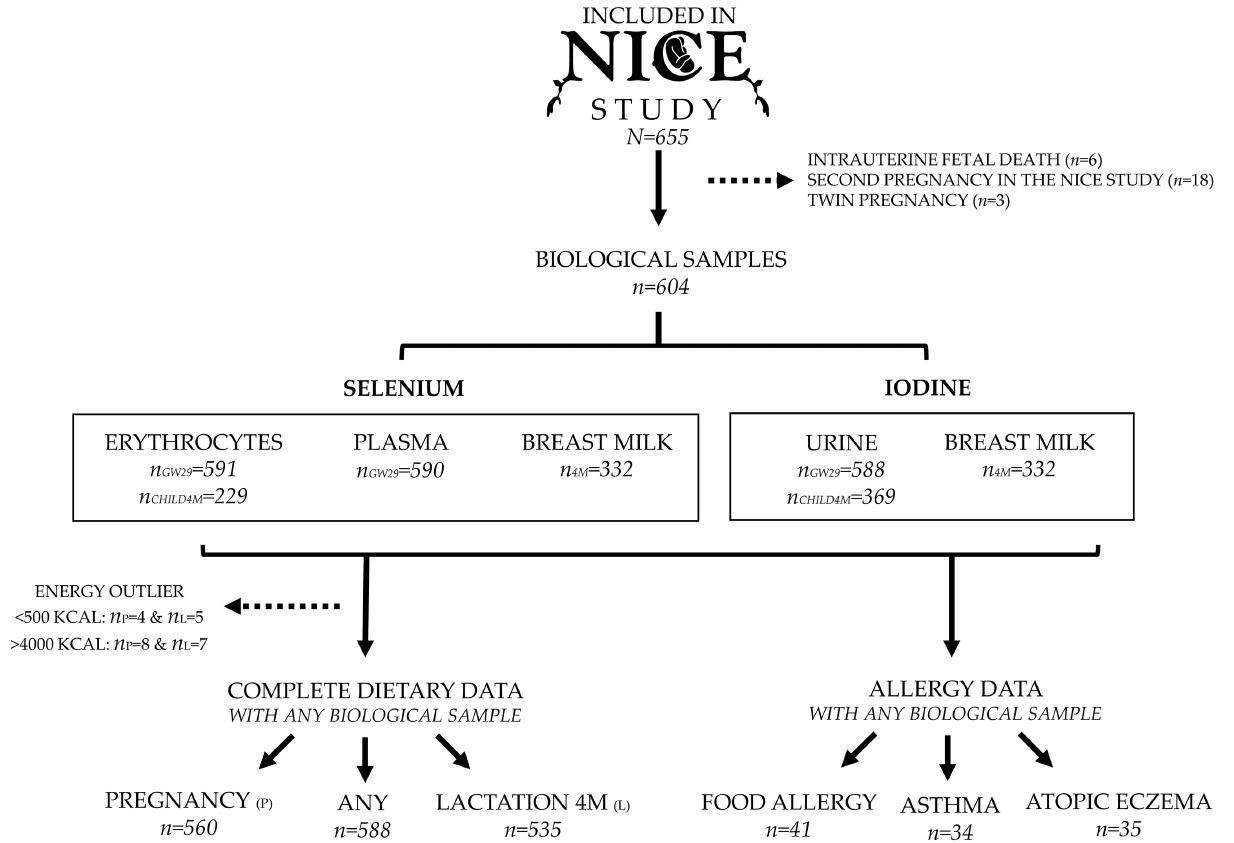
FIGURE 1 | Flow chart of inclusion of pregnancies, number of available samples for measurements of iodine and selenium, and prevalence of allergic disease at 12 months of age.